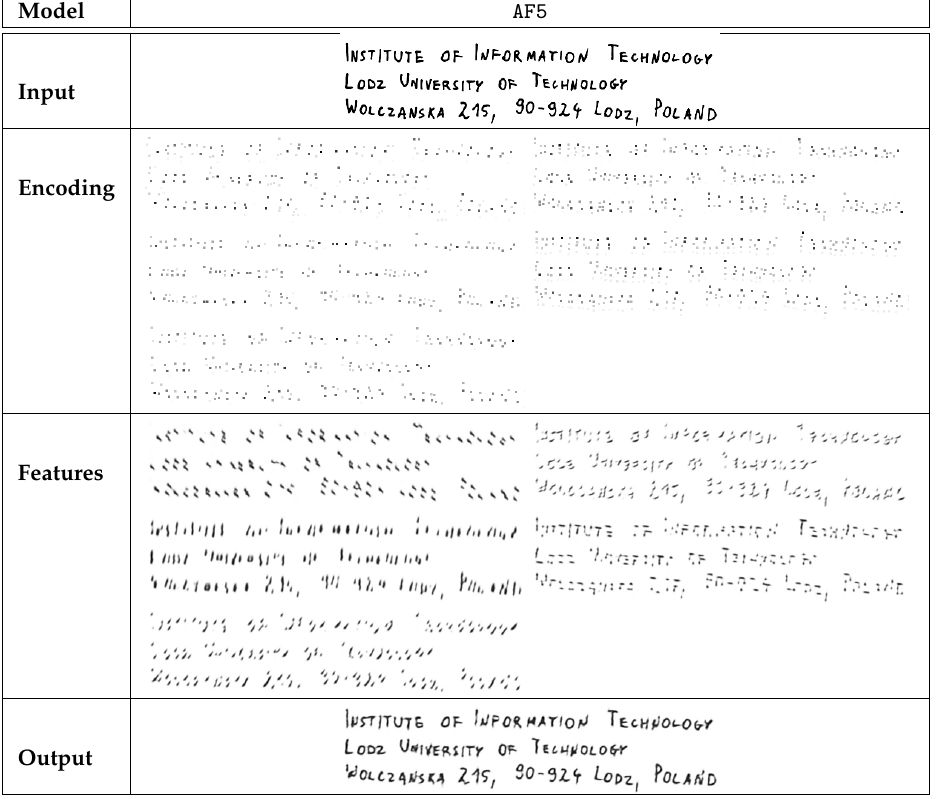
Figure 16. Sample encoding of a postal address scan that contains both digits and letters, performed with the AF5 model. The presented feature-specific decodings were generated in the same way as those shown in Figure